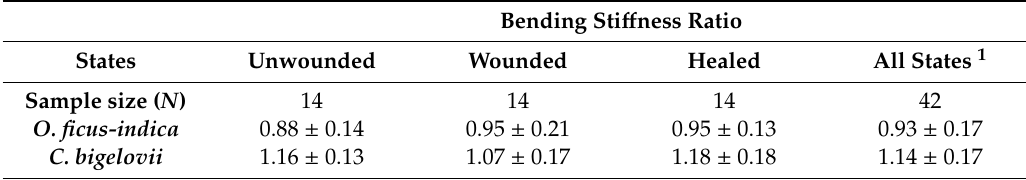
Note: Bending sti ff ness ratios do not di ff er significantly between states for the two species. 1 The pooled data of all states significantly di ff er from one for O. ficus-indica (one-sample t-test, t = − 2.92, df = 41, p = 0.005) and C. bigelovii (one-sample t -test, t = 5.19, df = 41, p <